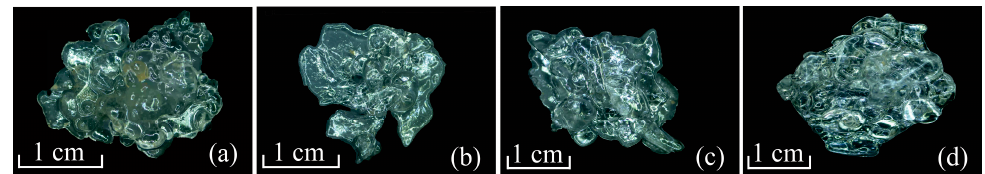
Figure 10. Multiple frazil particles agglomerated together.